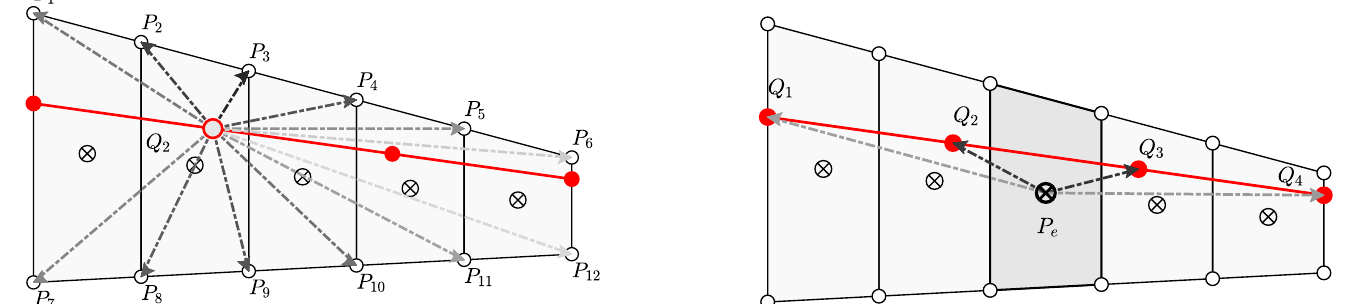
Figure 2. Scheme for motion interpolation ( left ) and force and moment transfer ( right ). Structural points are represented by red dots. Nodes of the aerodynamic mesh and panels centers are represented with plain dot and crosses,